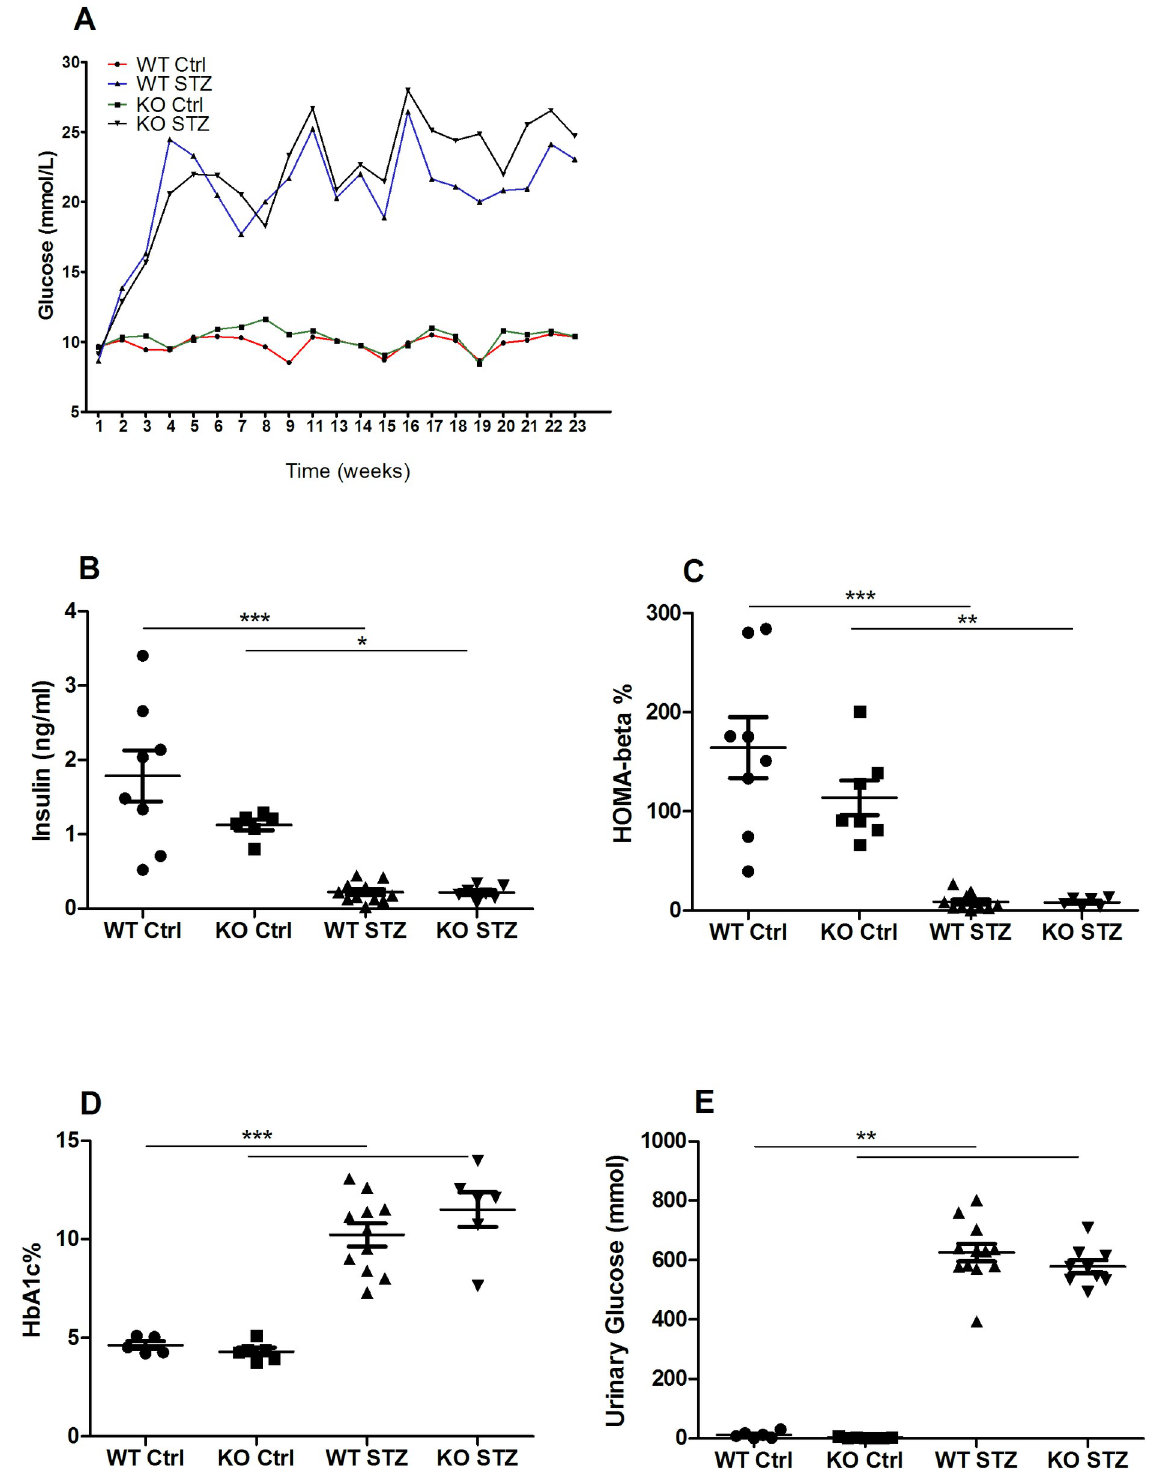
Fig 2. Diabetic parameters: Blood glucose, fasting insulin, HOMA-beta, HbA1c, and urinary glucose. (A) Weekly blood glucose measured with the Contour XT glucose meter. (B) Fasting plasma insulin measured with the Ultra-Sensitive Mouse Insulin ELISA kit. (C) HOMA-beta percentage was calculated using fasting blood glucose and plasma insulin values. (D) HbA1c measurement was measured in whole blood using the Mouse Hemoglobin A1c (HbA1c) Assay Kit. (E) Urinary glucose excretion measured in 24-hour urine in the automated Roche cobas c702